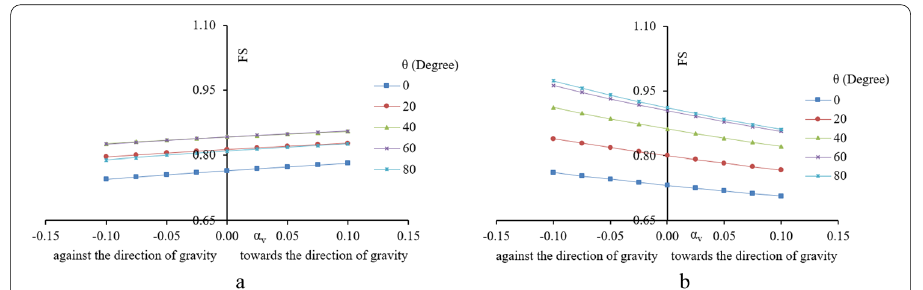
Fig.11 FS vs α v on different values of θ : a case 1 and b case